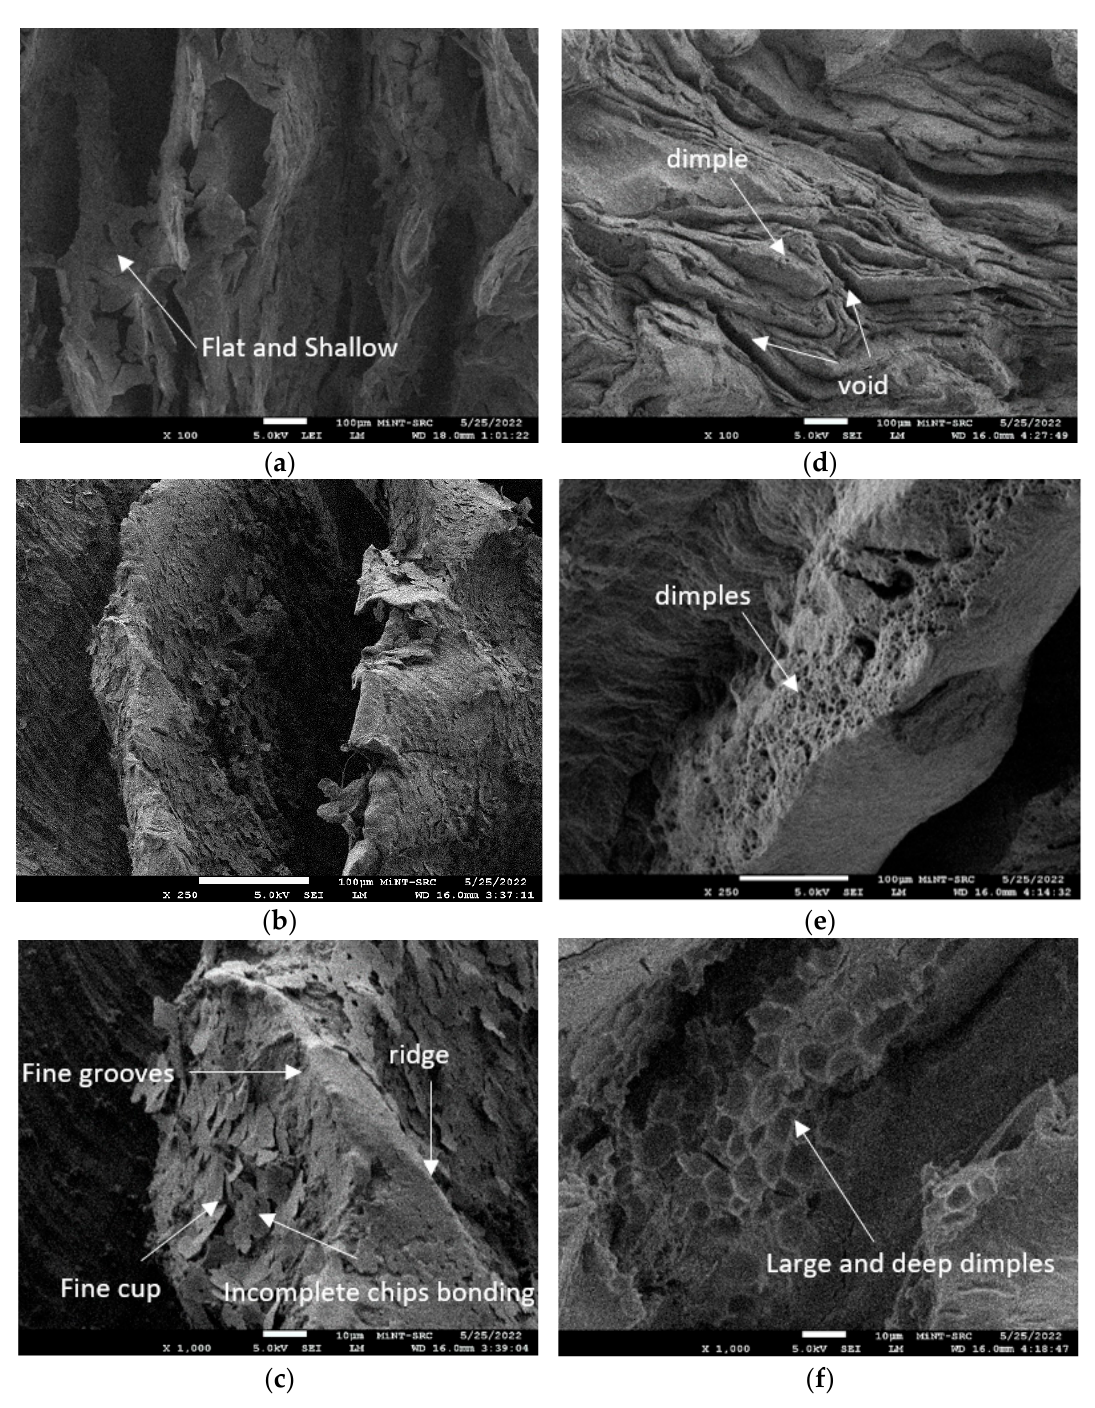
Figure 7. FESEM micrographs for surface fracture at minimum–maximum parameters: ( a ) an overview of the S1 fracture surface at 100×, ( b ) the periphery coarse topology of S1 at 250×, ( c ) equiaxed dimples of S1 at 1000×, ( d ) an overview of the S9 fracture surface at 100× ( e ) the periphery coarse topology of S9 at 250×, ( f ) the equiaxed dimples of S9 at 1000×. At the maximum parameter, many microvoids and dimples can be seen, indicating the ductile fracture mode. The presence of deep and large dimples in Figure 7f indicates that the specimen has a high fluent strain. The maximum parameter has the highest ETF value, which is 6.92%. The higher temperature results in low stress and more ductility. The higher temperatures enhance ductility, allowing for greater plastic deformation [74]. 3.2.3. Density and Microhardness Analysis Figure 8 represent the overall density graph and microhardness graph at different parameters. As seen in Figure 8, the density and microhardness values increased with the increasing operating temperature and time. The minimum and maximum values of